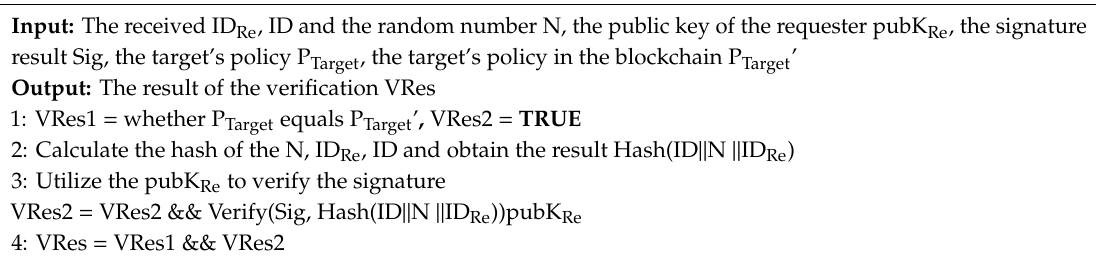
Algorithm 1 Verify the validity of access